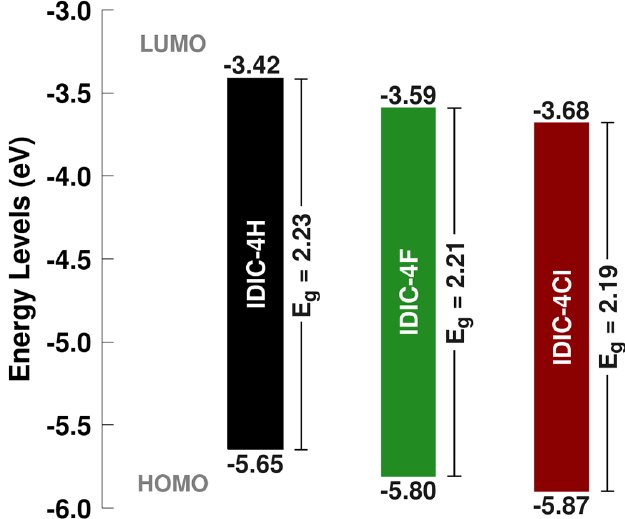
Fig. 3. HOMO, LUMO energy levels for the three compounds. The related energy gaps are also displayed.